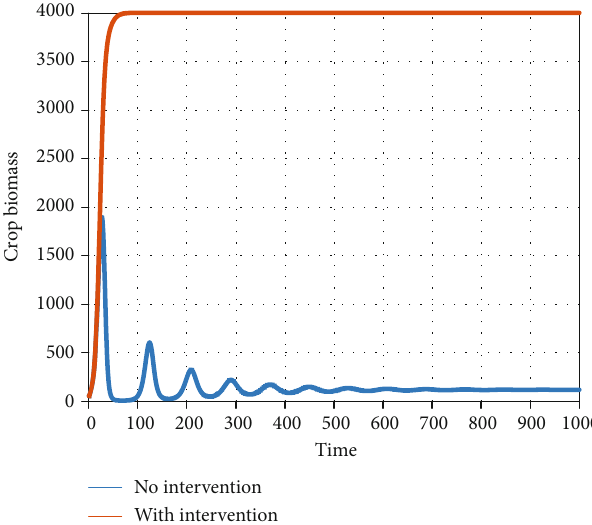
Figure 3: Impact of integrated early intervention on crop biomass. The simulation was conducted in the absence of intervention ( θ = θ = γ = γ = 0 ) and within intervention measures ( θ = 0 : 0025 0 1 2 , θ = 0 : 00025 , and γ = 0 : 00225 ). 0